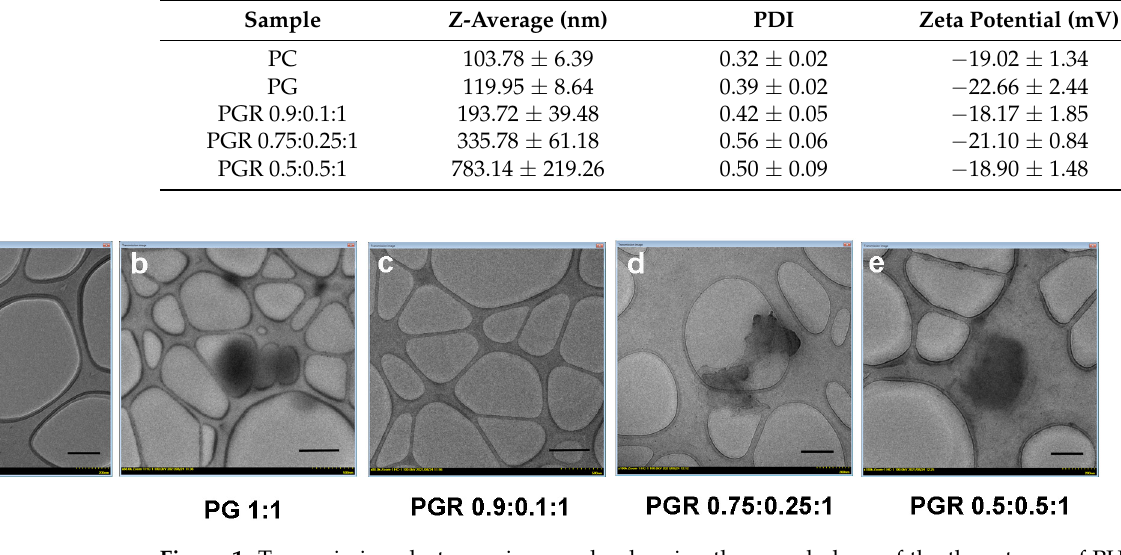
Figure 1. Transmission electron micrographs showing the morphology of the three types of PHY- TOGINROSA (PGR) formulations compared to phosphatidylcholine (PC) and PHYTOGIN (PG); ( a , d , e )—scale bar 200 nm, ( b , c )—scale bar 500 nm.